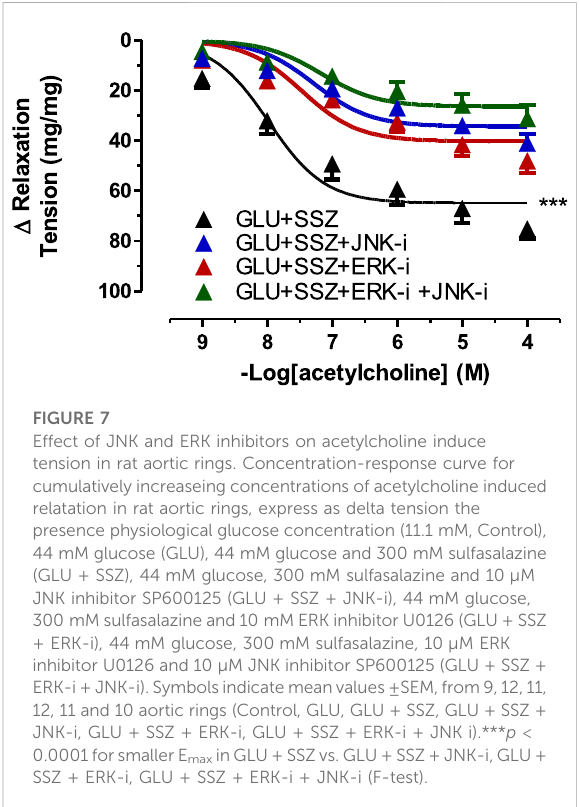
FIGURE 8 (A) Effect of ERK and JNK inhibitors on the heme oxhgenase- 1. The heme oxhgenase-1(HO-1) concentrations (ng/ml) in rat aortic rings, express the presence physiological glucose concentration (11.1 mM, Control), 44 mM glucose (GLU), 44 mM glucose and 300 mM sulfasalazine (GLU + SSZ) 44 mM glucose, 300 mM sulfasalazine and 10 µM JNK inhibitor